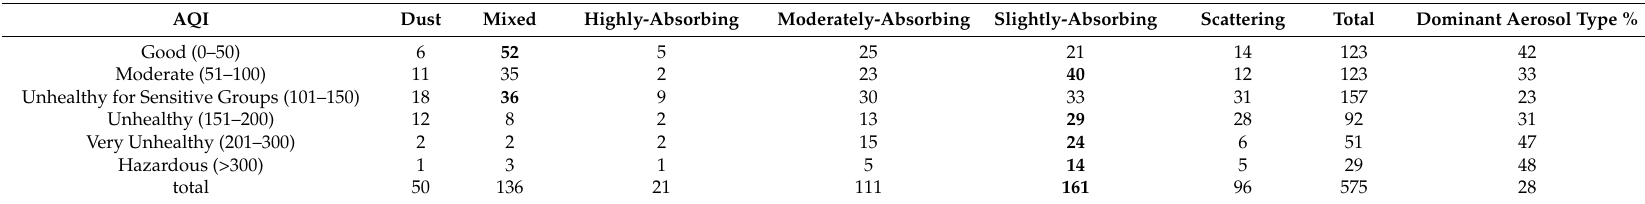
Table 2. The percentage of aerosol types in different air quality levels (2013–2015) by the range groups of the daily average of AQI at the BJ site. N = 575 (the values in bold are the days of the dominant aerosol types).